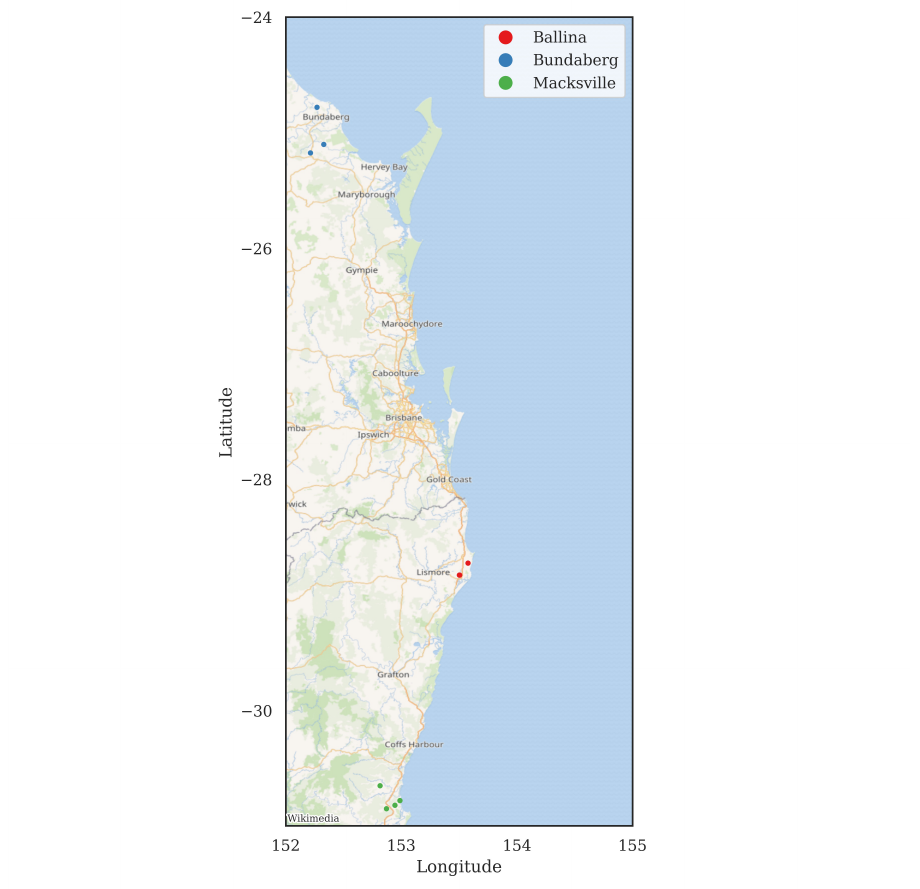
Figure 1. Locations of the macadamia orchards (each encompassing multiple blocks), grouped into the three